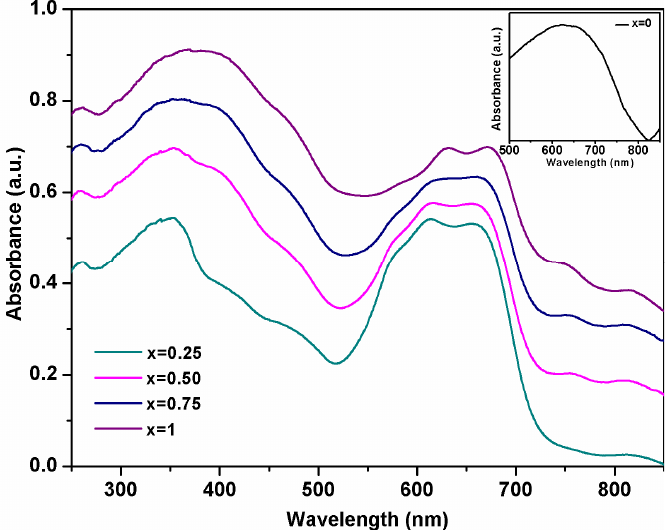
Figure 7. UV–Vis spectra of Co (1 − x) Ni x Cr 2 O 4 pigment (x = 0, 0.25, 0.5, 0.75 and